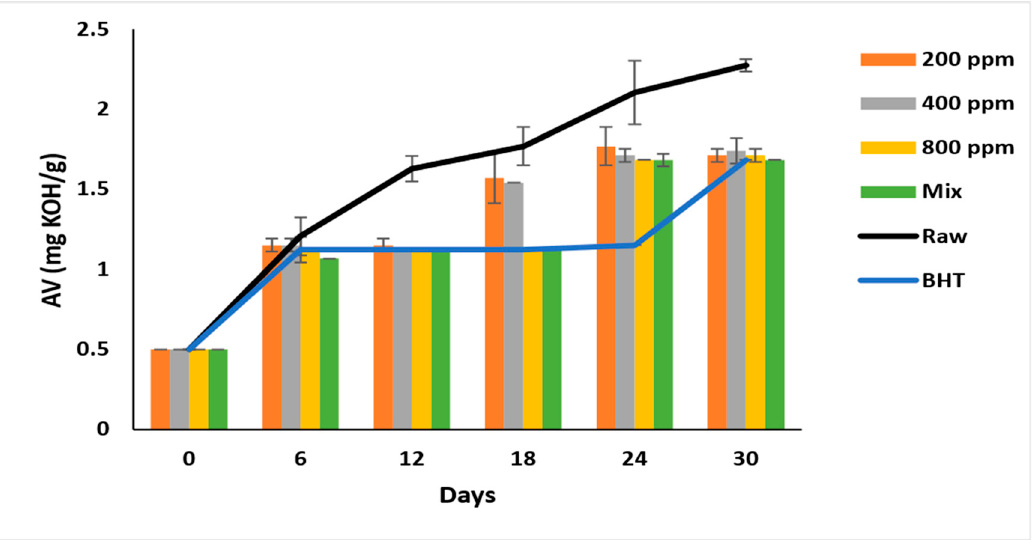
Figure 1. Acid value (mg KOH/g oil) of raw soybean oil (without antioxidants) and soybean oil enriched with PGG leaves extract (200, 400, and 800 ppm), BHT (200 ppm), and a PGG/BHT mixture (400/100 ppm) during the accelerated storage days (30 days) at 65 °C.